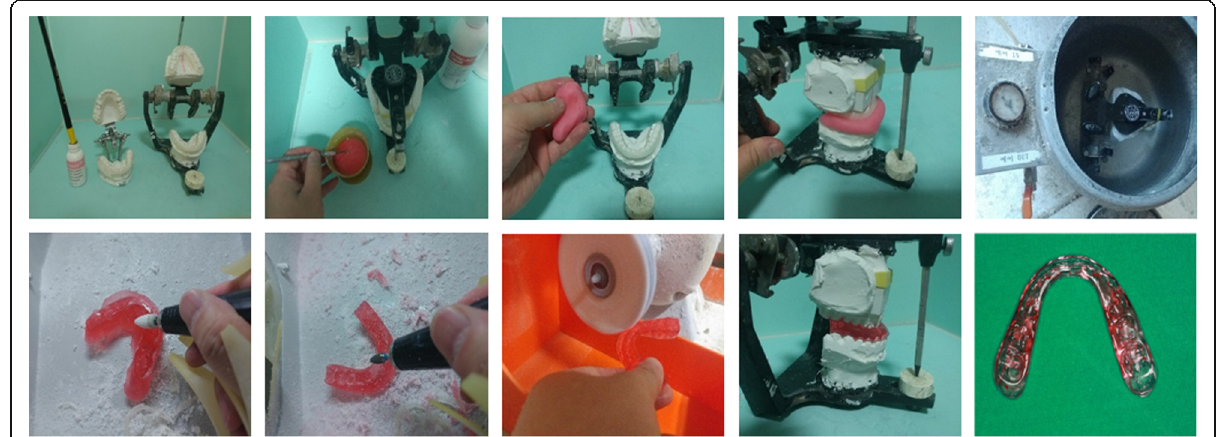
Fig. 1 Stent fabrication progress in conventional surgical planning